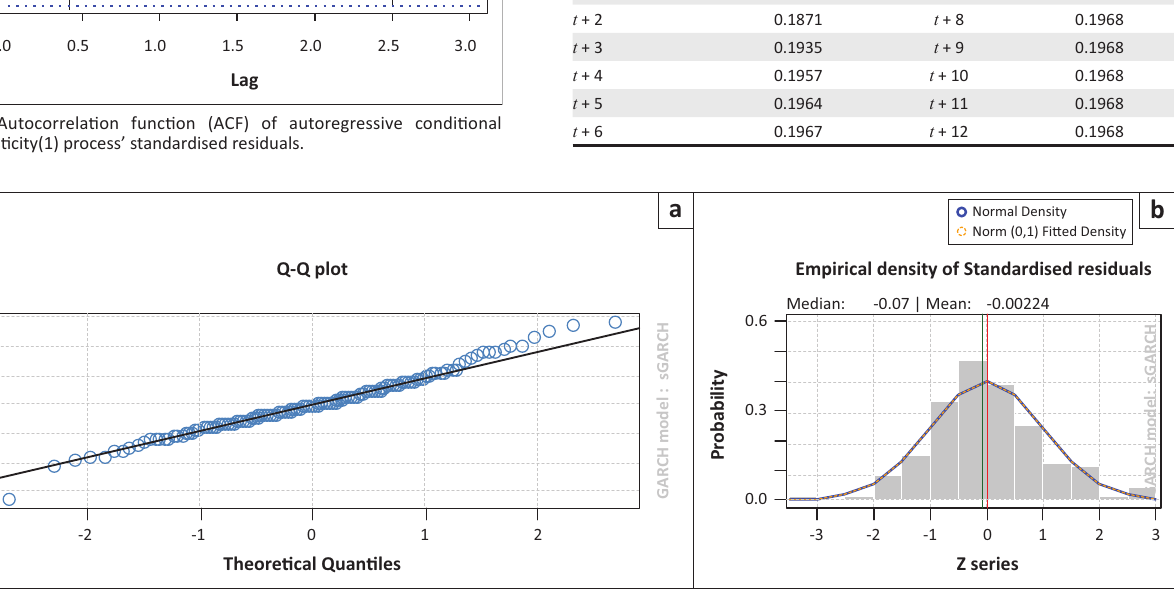
FIGURE 4: Q-Q plot and probability density plot of the autoregressive conditional heteroscedasticity(1) process’ standardised residuals.